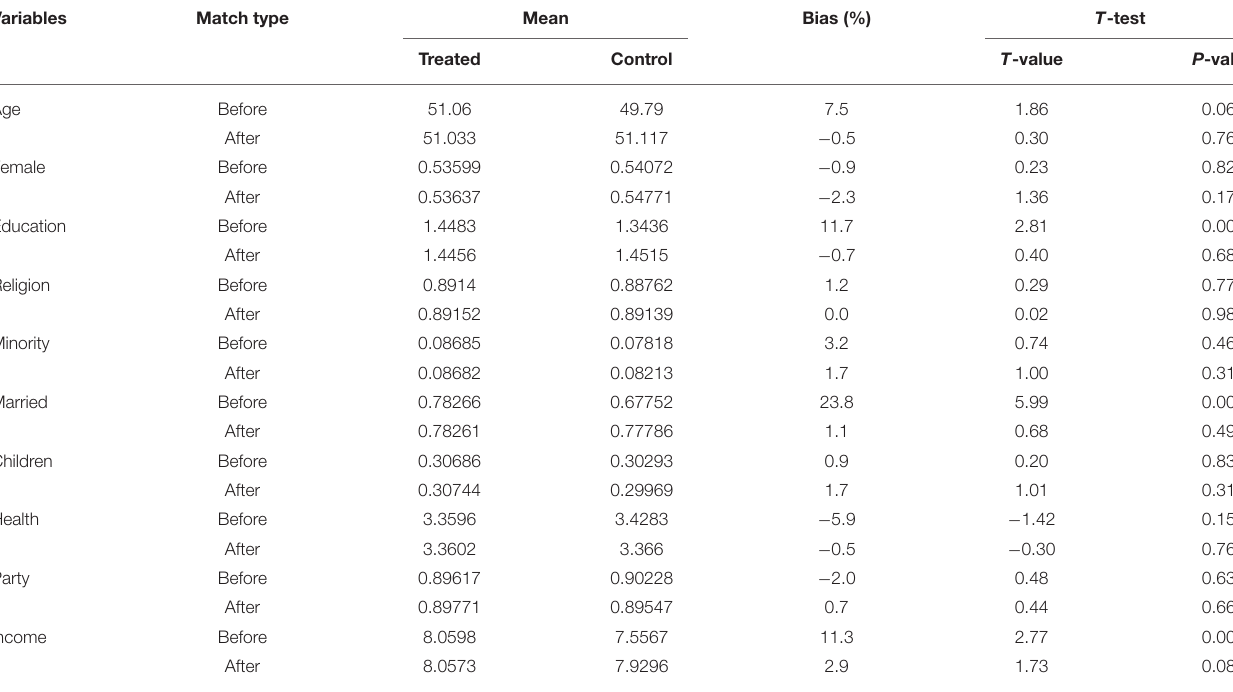
TABLE 3 | Balance